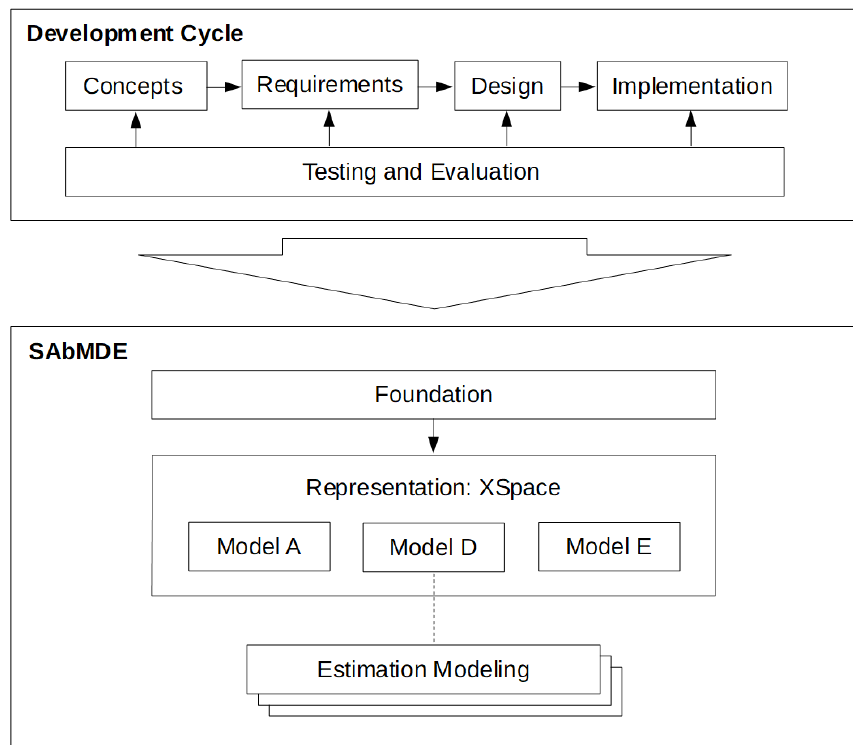
Figure 1. Development modeling